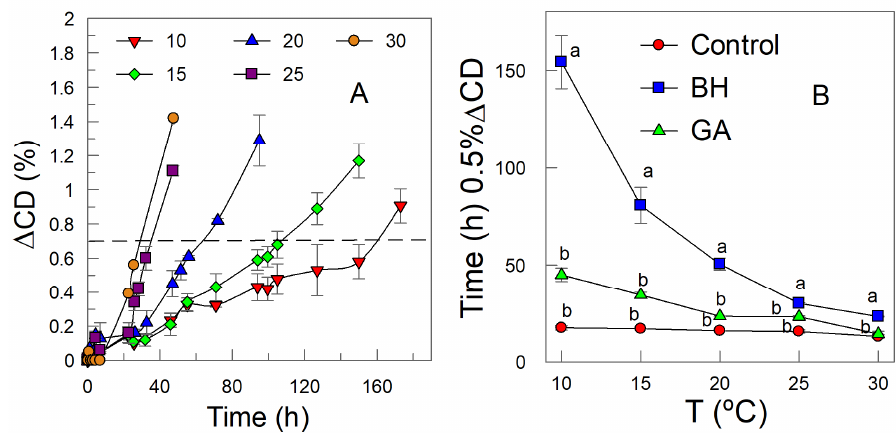
Figure 4. ( A ) Oxidative stability in terms of the variation in CDs formation of 4:6 (O / W) stripped fish oil-in-water emulsions containing BH Bryophyllum extracts (TPC 500 µ M GAE) at di ff erent temperatures ( Φ I = 6.68%, pH = 3.0, 0 rpm). The dashed line marks the hours required for a 0.5% CDs increase. ( B ) E ff ect of the temperature (10 ◦ C–30 ◦ C) in 4:6 (O / W) emulsions containing BH Bryophyllum extracts on the time needed to reach 0.5% ∆ CD. Data were expressed as average ± standard deviation and di ff erent letters indicate significant di ff erences ( α = 0.001).